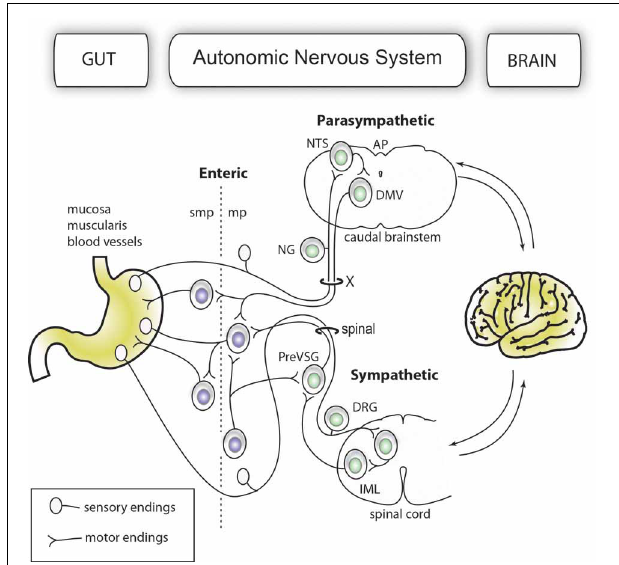
FIGURE 1 | Simplified organization of the gut-brain axis. The main anatomical and functional subdivisions of a mammalian gut-brain axis are represented with neurons belonging to the enteric and extrinsic autonomic systems in different colors. Importantly, the enteric nervous system is entirely contained within the gastrointestinal wall. For purposes of simplification, all the nerve branches supplying the gut, pancreatic post-ganglionic neurons and the sacral parasympathetic system are not depicted in this